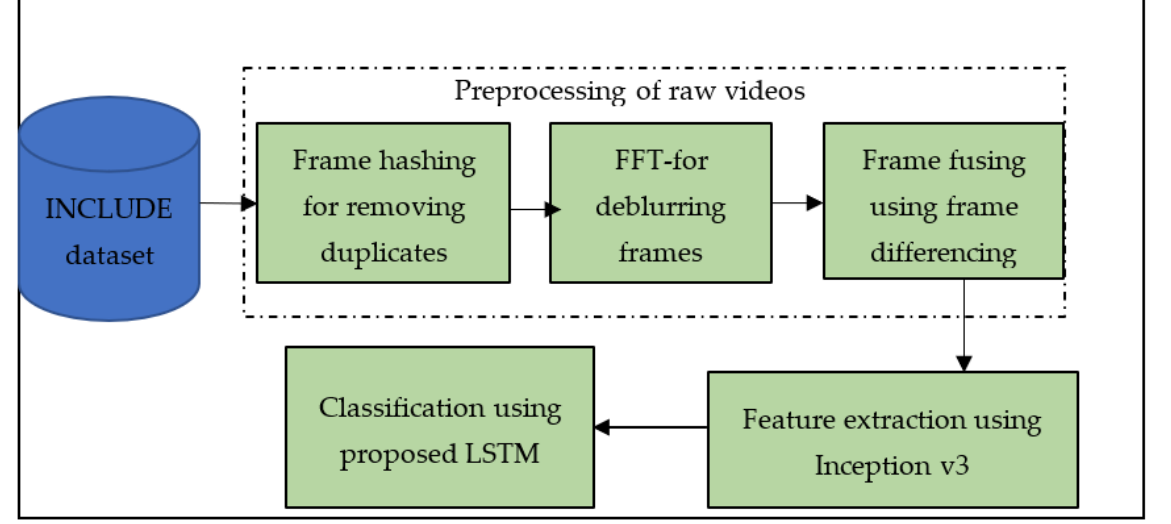
Figure 1. Workflow of the proposed sign language translator model.